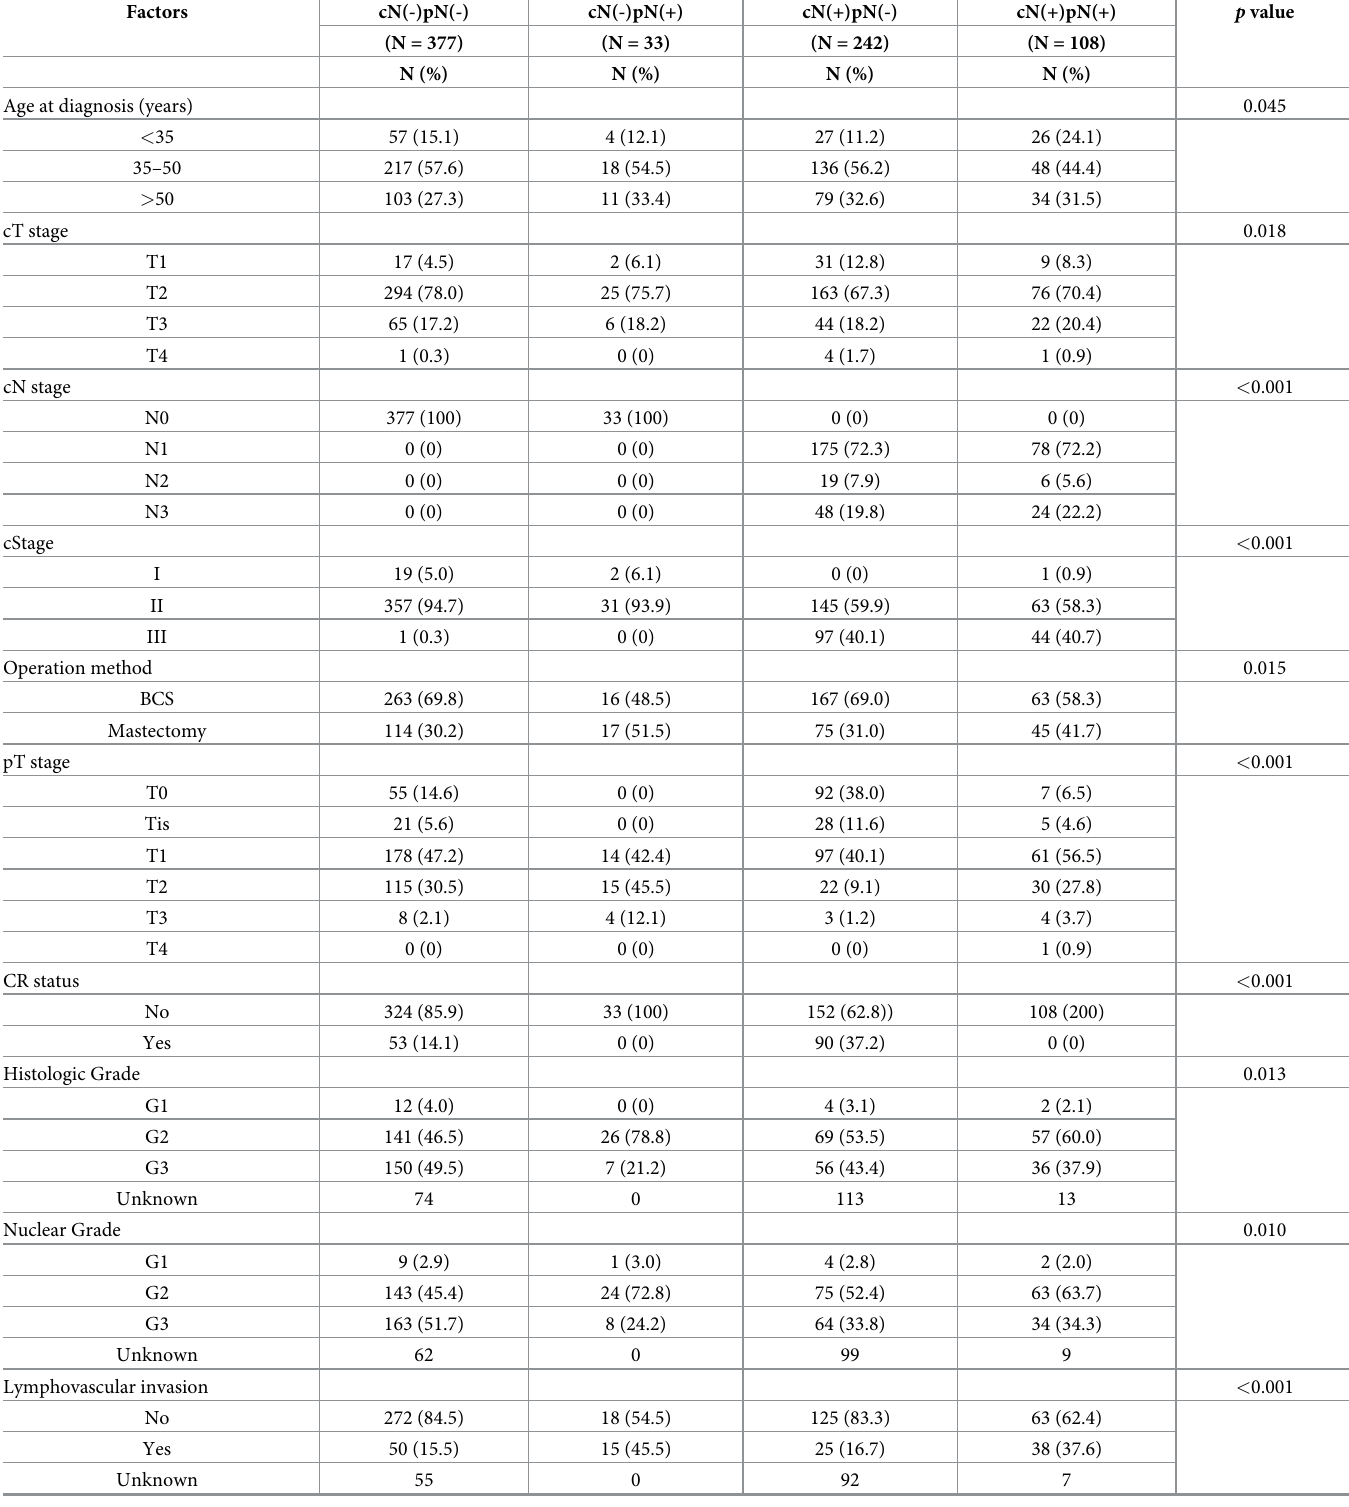
Table 2. Comparison of patients’ characteristics according to their lymph node